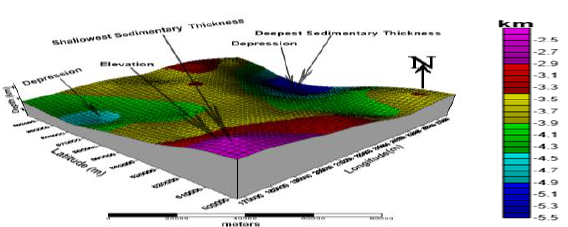
Figure 11: 3D map of the study area showing magnetic basement topography.